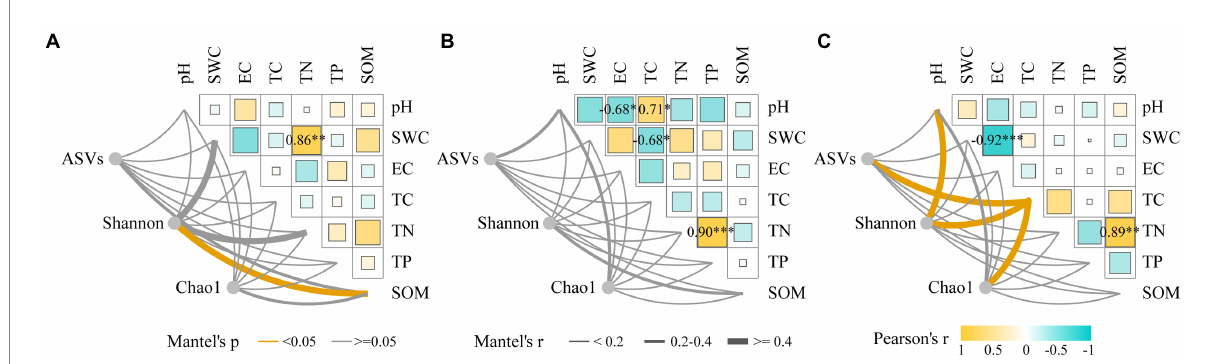
FIGURE 1 Correlation between environmental factors and alpha diversity indices of Nitraria tangutorum rhizosphere soil under different stress ( A : CK; B : Drought; and C : Salt). Pairwise comparisons of environmental factors are shown with a color gradient denoting Pearson’s correlation coefficient. The number of ASVs, Shannon and Chao1 indices were correlated with each environmental factor by Mantel